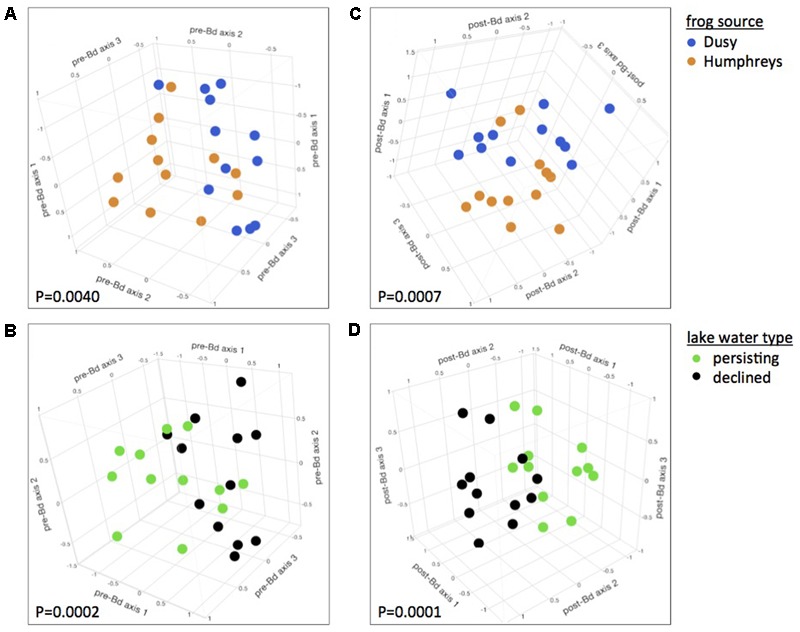
Effects of host and aquatic environment on the skin microbiome. Skin bacterial communities were significantly different between frogs from the two source populations prior to Bd infection (A) and differences persisted after Bd infection (C). Frogs housed in water from persistent and die-off field sites had different microbiomes, (B) and these differences persisted after Bd infection (D). Plots are 3-dimensional NMDS ordinations of R. sierrae skin-associated bacterial communities, pooled by treatment, sampled on day 21 of the experiment (after 3 weeks of water treatments, and before Bd infection, left panels), and day 43 (21 days after Bd exposure, right panels). Plots are rotated to display treatment differences. Marker colors indicate Frog Source (top) or Lake Water Type (bottom). NMDS stress: (A,B) 0.06; (C,D) 0.1.